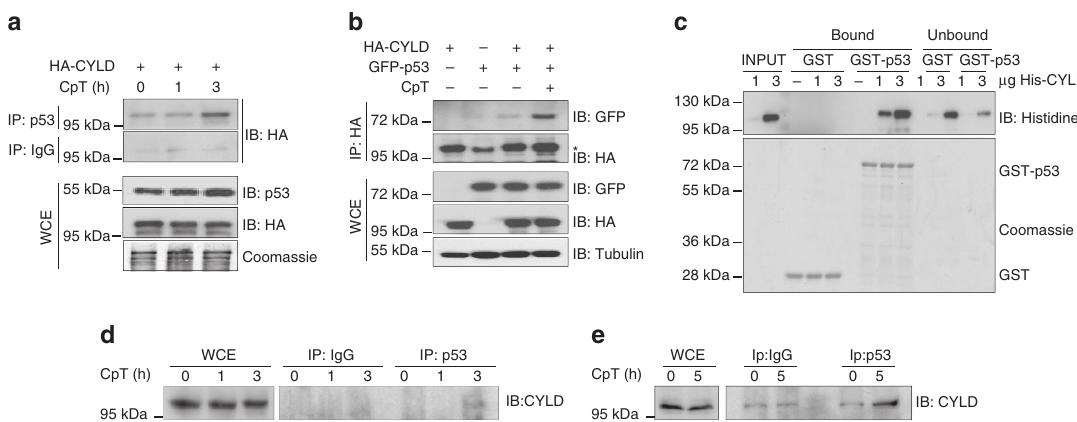
Figure 6 | CYLD and p53 interact in response to DNA damage. ( a ) p53 immunoprecipitation from CpT-treated HEK-293T cells transfected with the indicated plasmids. Immunoblot with anti-HA antibodies shows co-immunoprecipitated HA-CYLD. Expression levels of p53 and HA-CYLD in whole cell extracts (WCE) are shown. ( b ) HA-CYLD immunoprecipitation from CpT-treated HEK-293T cells transfected with the indicated plasmids. Immunoblot with anti-GFP antibodies shows co-immunoprecipitated GFP-P53. Expression levels of GFP-p53 and HA-CYLD in WCE are shown. *corresponds to an IgG nonspecific band. ( c ) GSTpull-down assay showing direct interaction between GST-p53 and His-CYLD. Coomassie staining shows equal amount of GST and GST-p53 proteins. Endogenous p53 was immunoprecipitated from primary keratinocytes ( d ) and HCT116 cells ( e ) treated with CpT for the indicated time points. Immunoblot with anti-CYLD antibodies shows the co-immunoprecipitated CYLD. Endogenous CYLD levels in WCE are